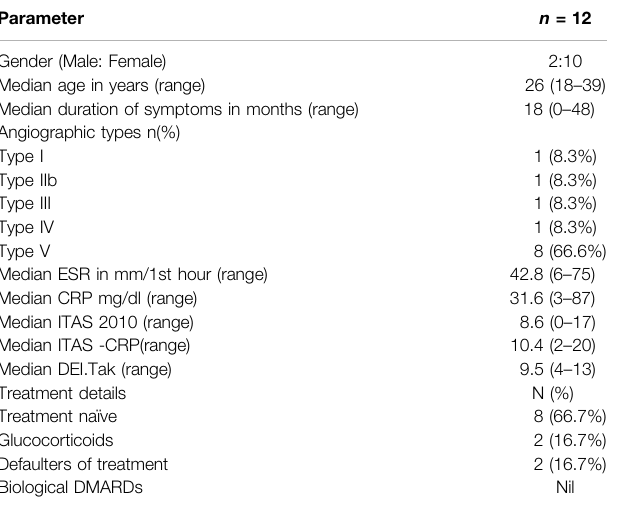
TABLE 1 | Clinical details of patients with TA.